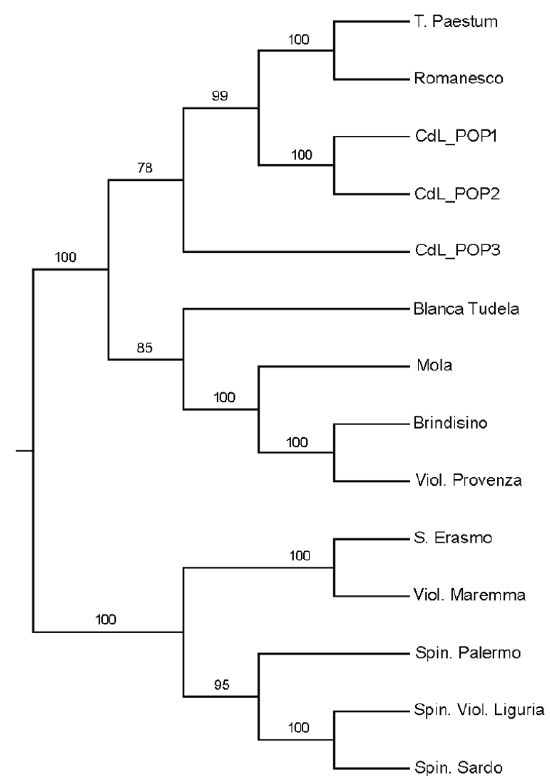
Figure 4. UPGMA dendrogram based on SSR markers in some artichoke landraces. CdL: Carciofo di Lucera. Numbers above branches indicate bootstrap values.